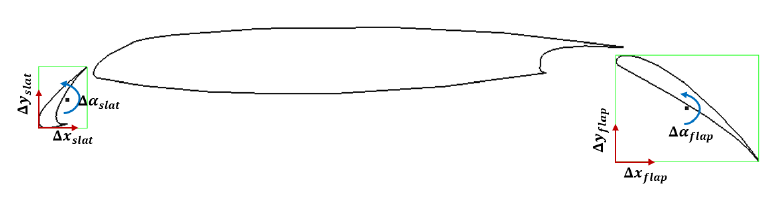
Figure 11. Parameterisation of a three-section aerofoil high-lift configuration.